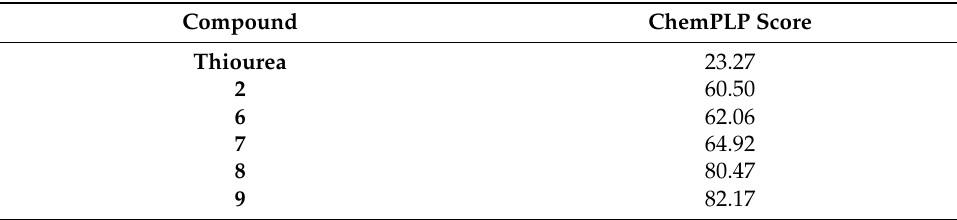
Table 2. Molecular docking results of thiourea and the oxime compounds 2 , 6 , 7 , 8 , and 9